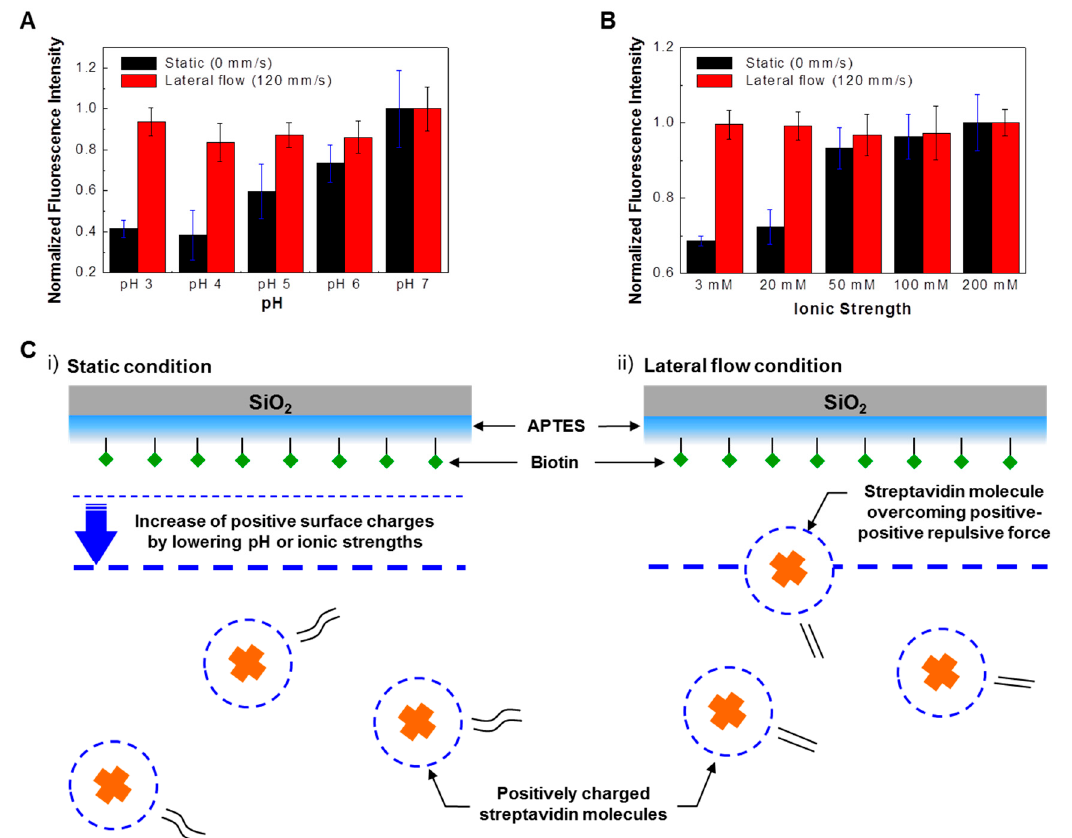
Figure 5. Effect of lateral flows on streptavidin-biotin reactions under various pH and ionic strength conditions: ( A ) Normalized fluorescence intensities of bound FITC-labeled streptavidin molecules on biotinylated substrates under different pH and flow speed conditions; ( B ) Normalized fluorescence intensities of bound FITC-labeled streptavidin molecules on biotinylated substrates under different ionic strength and flow speed conditions; ( C ) Schematic diagrams depicting the movements of streptavidin molecules to a biotinylated substrate under ( i ) static conditions and ( ii ) lateral flow conditions in low pH or low ionic strength solution.